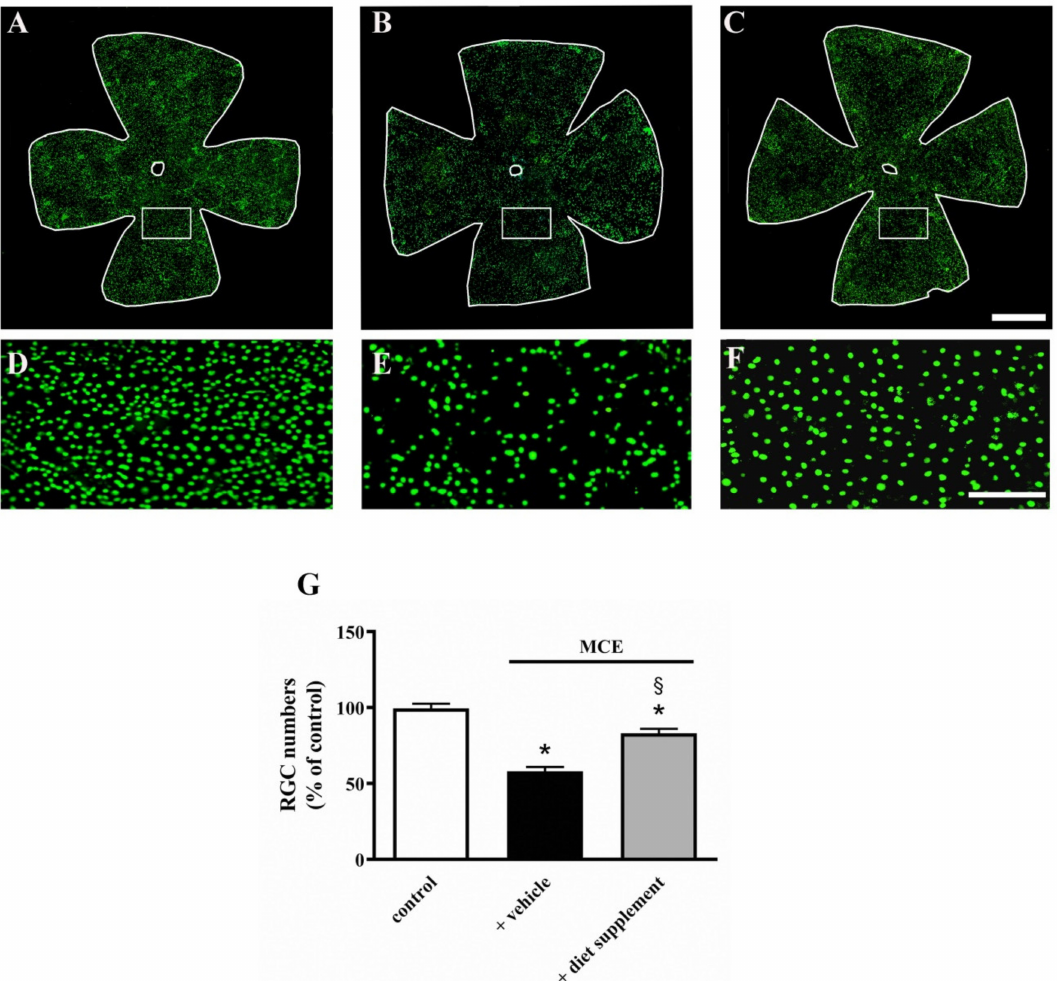
Figure 4. E ff ects of dietary supplementation on retinal ganglion cell (RGC) number. ( A – C ) Representative images of retinal whole mounts immunostained for brain-specific homeobox / POU domain protein 3A (Brn3a) in control mice ( A ) and in mice that received MCE either fed with either vehicle ( B ) or diet supplement ( C ) ( n = 5 for each experimental group). ( D – F ) High magnification